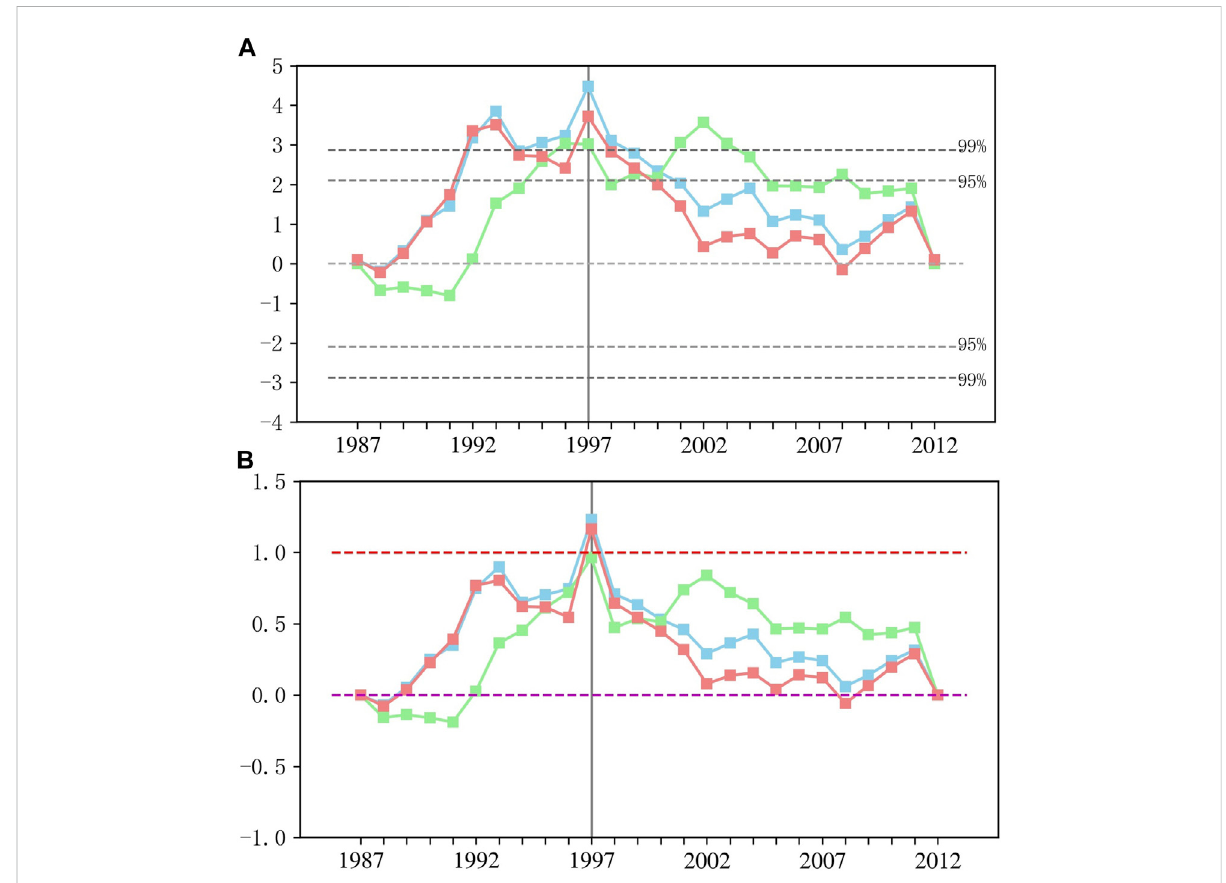
FIGURE 3 Moving t -test (A) and Yamamoto test (B) of extreme precipitation (blue line), extreme precipitation intensity (green lines), and extreme precipitation frequency (red lines).